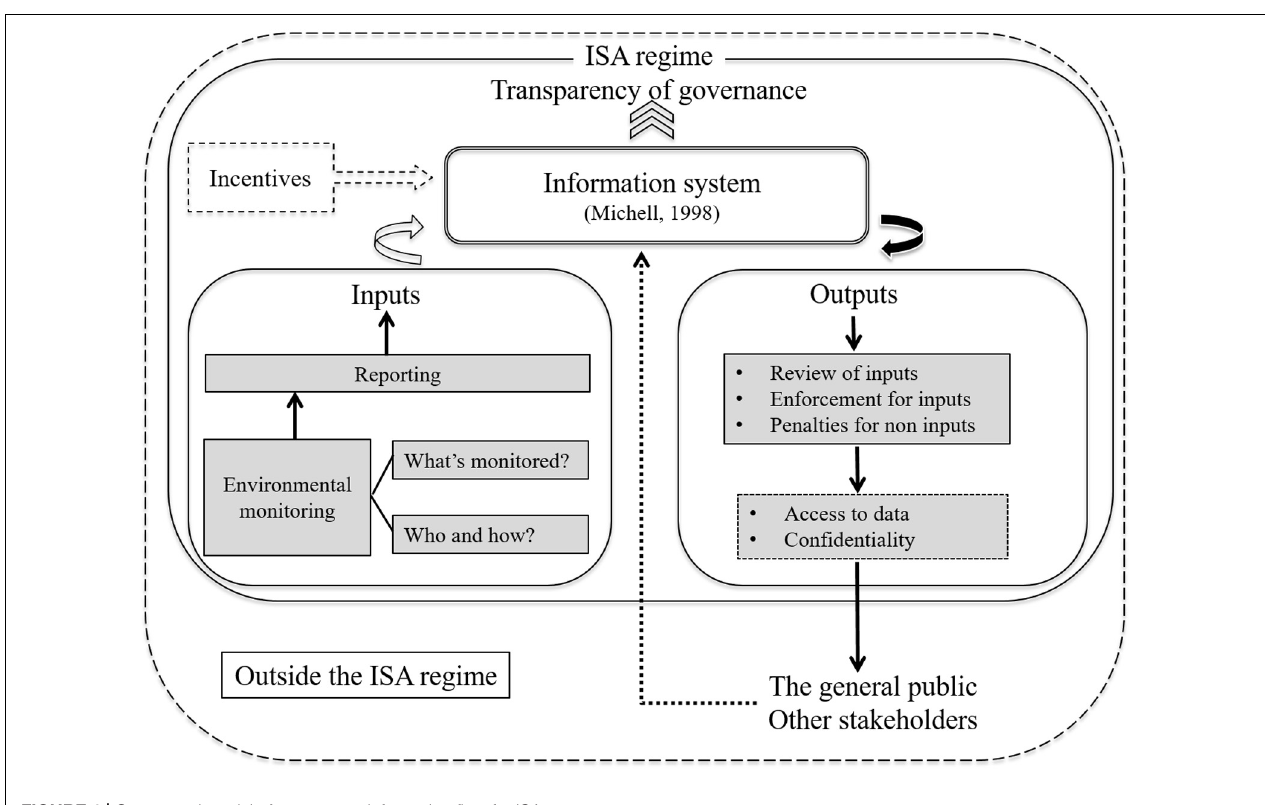
FIGURE 1 | Conceptual model of transparent information flow for ISA. TABLE 1 | Transparency directions, to whom, and criteria of good monitoring